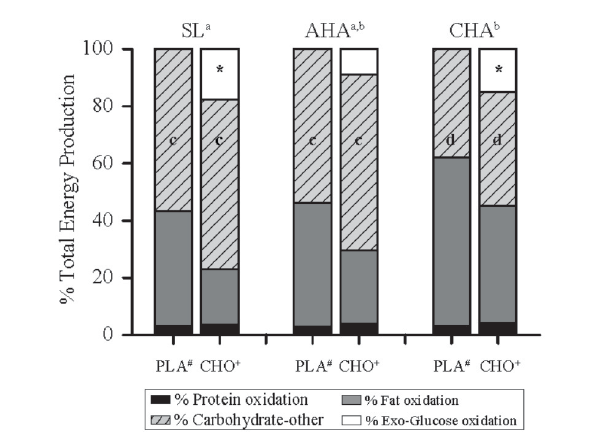
FIGURE 3 | Mean ± SD of exogenous glucose oxidation rate (g/min) during last 40 min of 80-min steady-state exercise (treadmill walking) in participants provided 1.8 g/min carbohydrate (CHO, n = 8, 65.25 g fructose + 79.75 g glucose) at sea level (SL) and at 4,300 m altitude, within 5–7 h after arrival (acute high-altitude, AHA) and again on the 22nd day of continuous residence at high-altitude (chronic high-altitude, CHA). Points not sharing same letter are different (lower case = main effect of time, P < 0.05; upper case = main effect of phase, P < 0.05). contributed more to total energy production at CHA than SL ( P < 0.05).